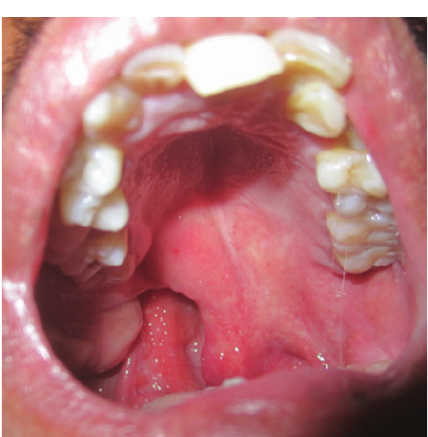
Figure 2: Right lateral view.